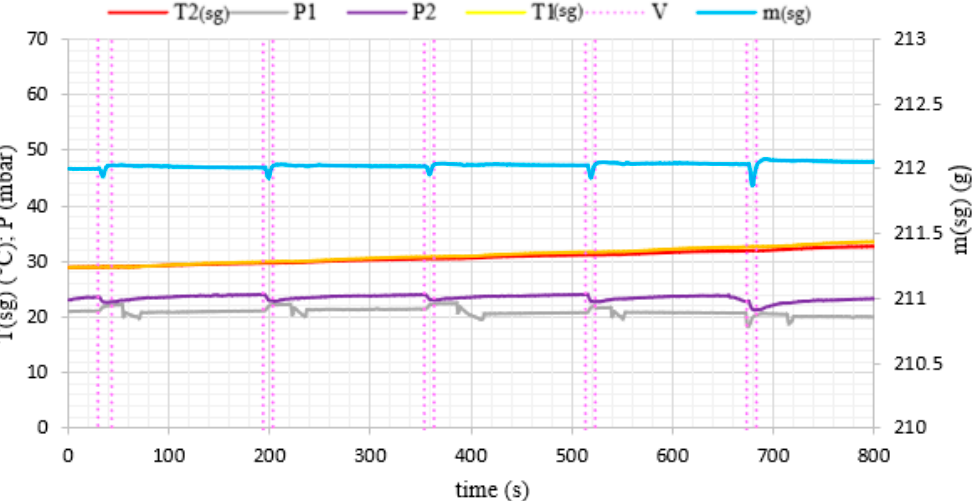
Figure 10. The changes of pressure, temperature and mass of evaporated water with time profiles in the adsorption chamber corresponding to fixed bed conditions (Irregular SG from Sigma Aldrich).